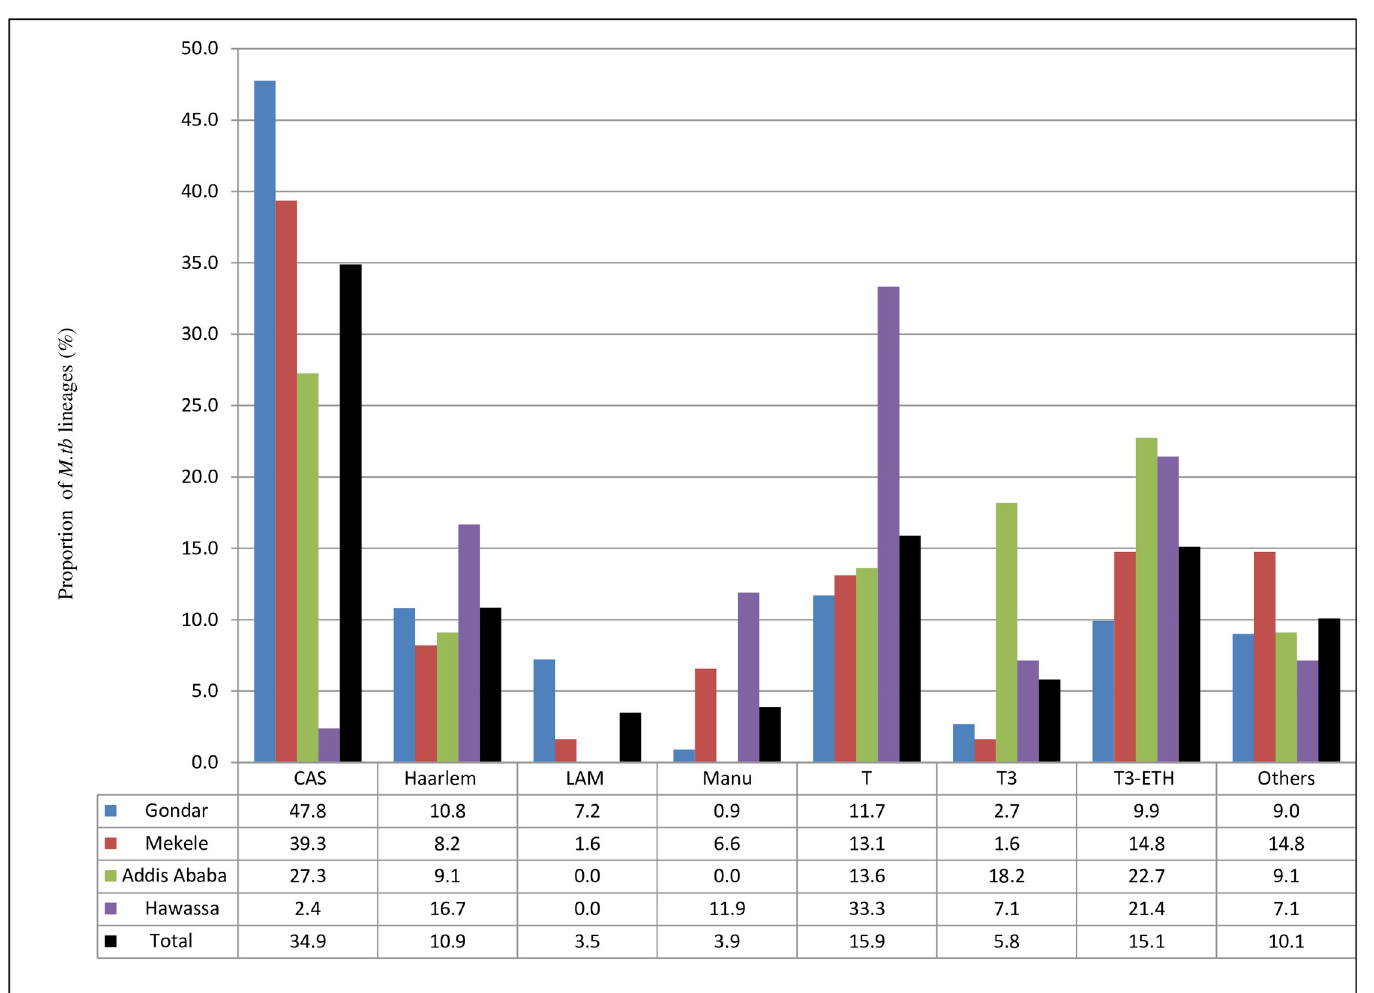
Fig 2. KBBN based classification of Mycobacterium tuberculosis sub-lineages circulating within peri-urban and urban areas in Ethiopia. H1, H3, H3-Ural-1 and H4-Ural-2 were classified as ‘Haarlem’; ‘LAM’ include LAM3 and LAM5; Manu represent Manu1 and Manu2. ‘Others’ include the following types: T2, Turkey, T1-RUS2, AFRI (Ethiopian), Beijing, EAI4-VNM, and EAI6-BGD1.